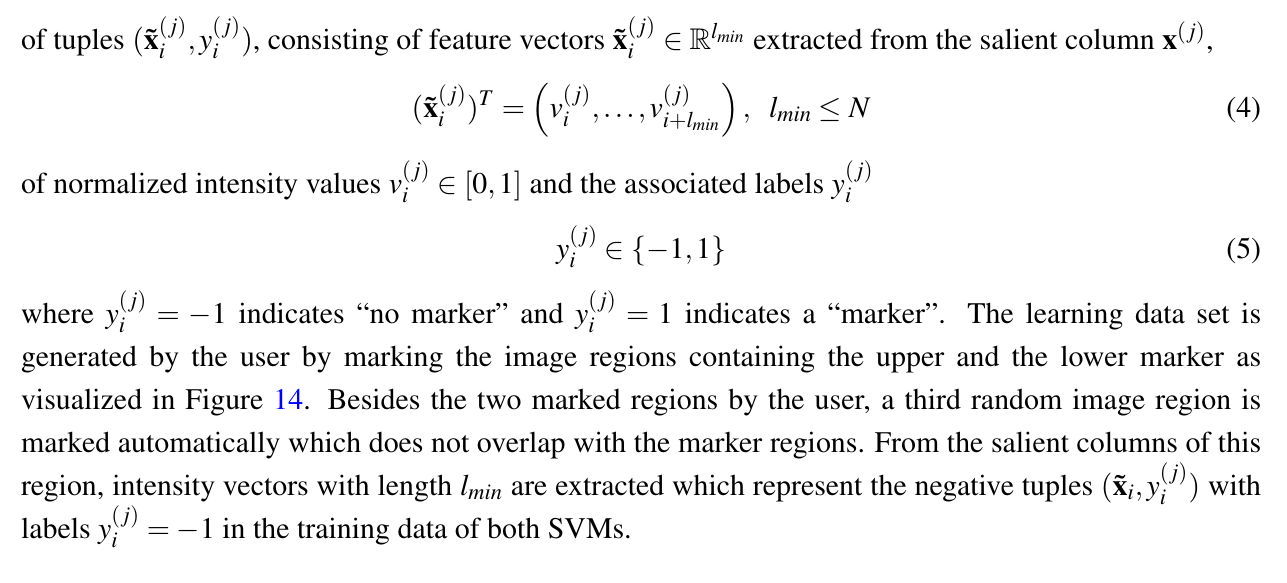
Figure 15. Schematic visualization of the learning classification model: extraction of feature vectors x i ∈ R l min for the learning set of the